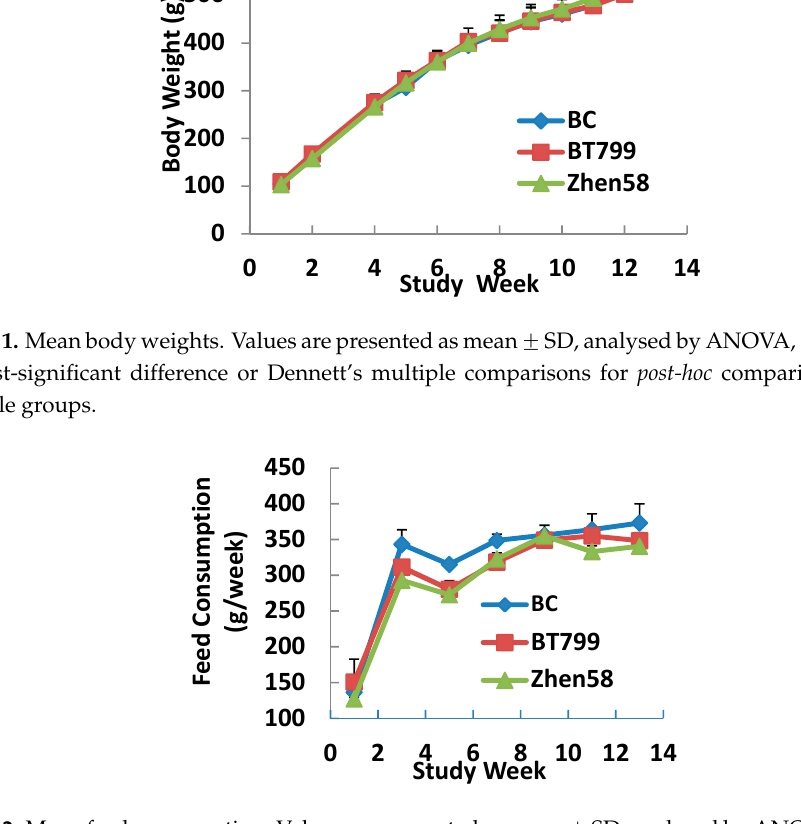
Figure 2. Mean feed consumption. Values are presented as mean ± SD, analysed by ANOVA followed by least-significant difference or Dennett’s multiple comparisons for post-hoc comparison between multiple